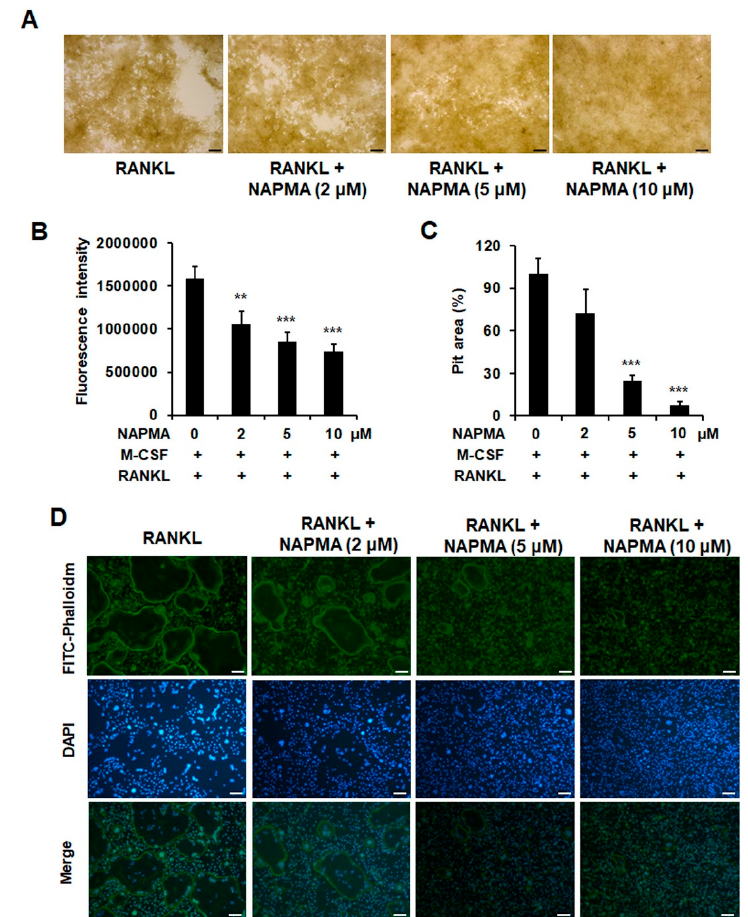
Figure 4. NAPMA inhibits osteoclast formation. ( A ) NAPMA inhibits bone resorption of mouse osteoclasts on bovine bone slices treated with dimethyl sulfoxide (DMSO) (control) or various concentrations of NAPMA for six days. Scale bar = 200 μ m. ( B ) Fluorescence intensity was measured at an excitation wavelength of 485 nm and an emission wavelength of 535 nm on a fluorometric plate reader. ( C ) The area of the resorption pits was measured. The data presented are the mean ± SD of three independent experiments. ** p < 0.01; *** p < 0.001. ( D ) NAPMA disrupts actin ring formation by mature osteoclasts. After culturing for 72 h, staining for actin ring formation was performed, followed by examination via fluorescence microscopy. Scale bar = 200 µ